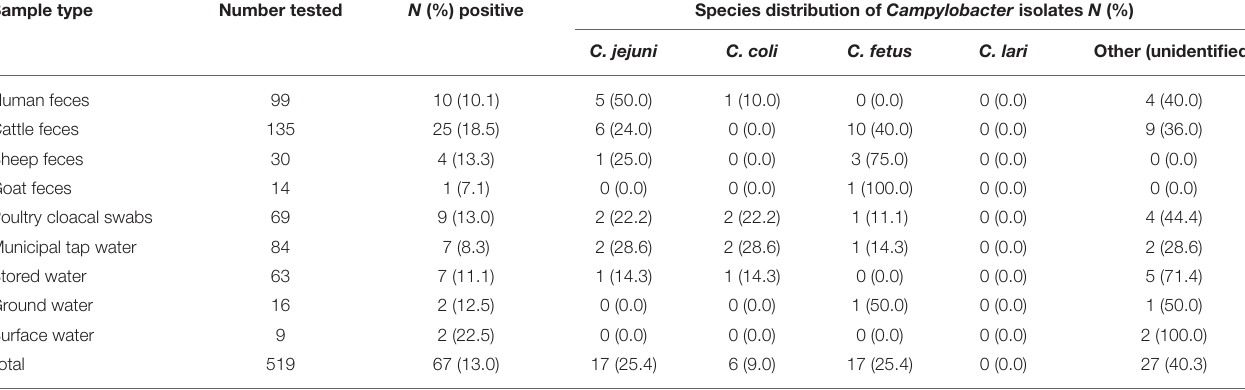
TABLE 1 | Campylobacter prevalence and species distribution across sample types. Sample type